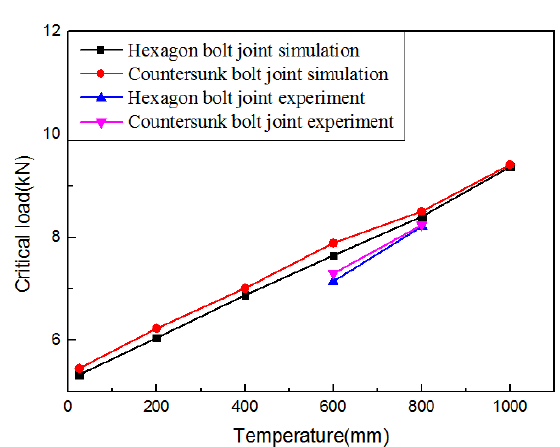
Materials 2019 , 12 , x FOR PEER REVIEW Figure 18. Diagram of variables r and l . Figure 18. Diagram of variables r and l .